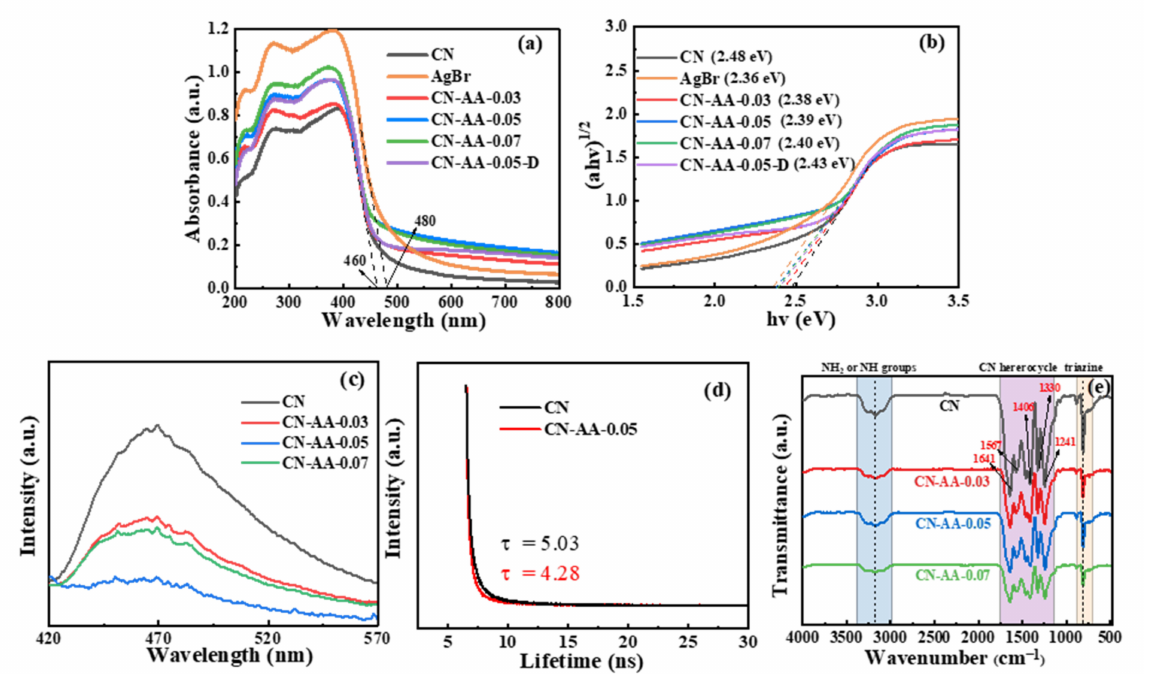
Figure 3. ( a ) UV–vis DRS and ( b ) plots of (ah ν ) 1/2 versus energy (h ν ) of CN, AgBr, CN-AA-X (X = 0.03, 0.05, 0.07), and CN-AA-0.05-D. ( c ) The PL spectra of CN and CN-AA-X (X = 0.03, 0.05, 0.07). ( d ) The time-resolved fluorescence decay spectra of CN and CN-AA-0.05. ( e ) The FTIR spectra of CN and CN-AA-X (X = 0.03, 0.05,